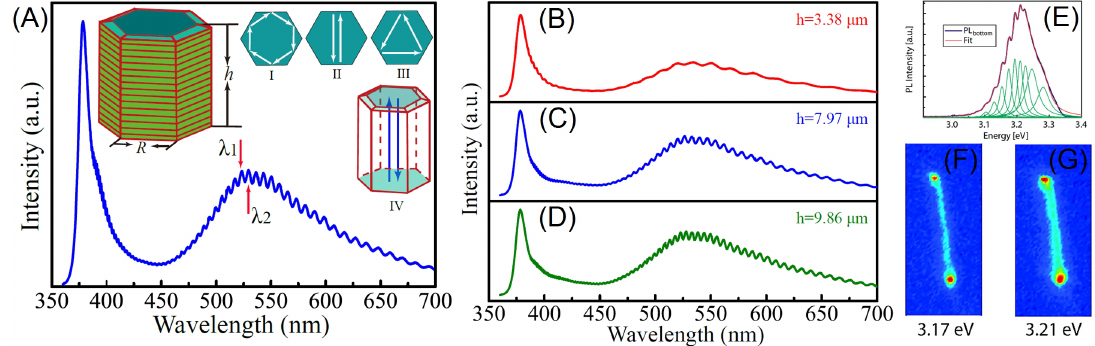
Figure 8: (A) PL spectrum from the individual ZnO microrod. Insets show the diagrams of the four light paths. (B–D) PL spectra collected at the center of the top facet of three ZnO microrods with different heights. (E) Analysis of the emission spectrum from a ZnO single nanowire at the bottom end as a sum of Fabry–Pérot peaks each with a Lorentzian line shape. (F, G) Map of the emission intensity along the nanowire at two different photon energies. Reproduced with permission from Ref. [98] (A–D) and [100] (E–G). PL: photoluminescence.